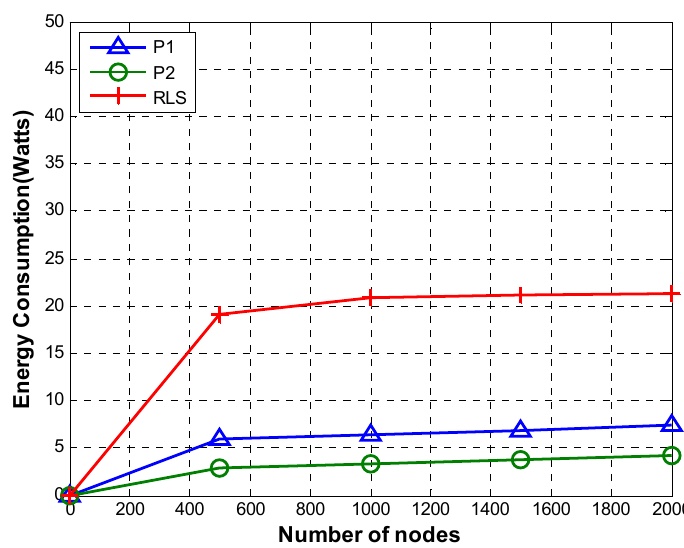
Figure 16. Energy consumption (sparsity).